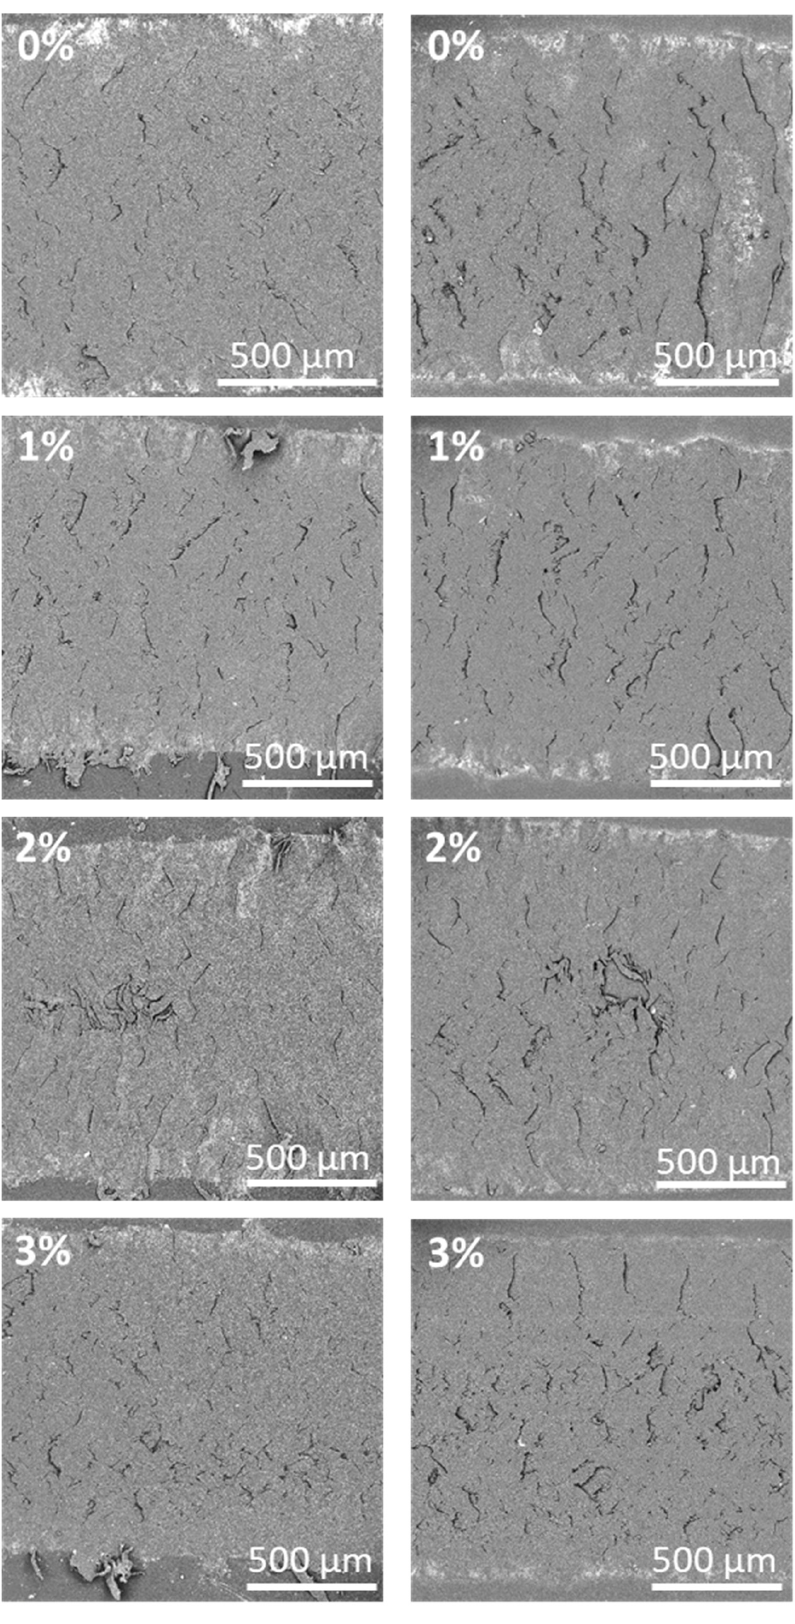
Figure 10. SEM micrographs of the wear mechanism of all PA11 coatings at 0 h ( left ) and 500 h ( right ) of exposure (magnification ×60).